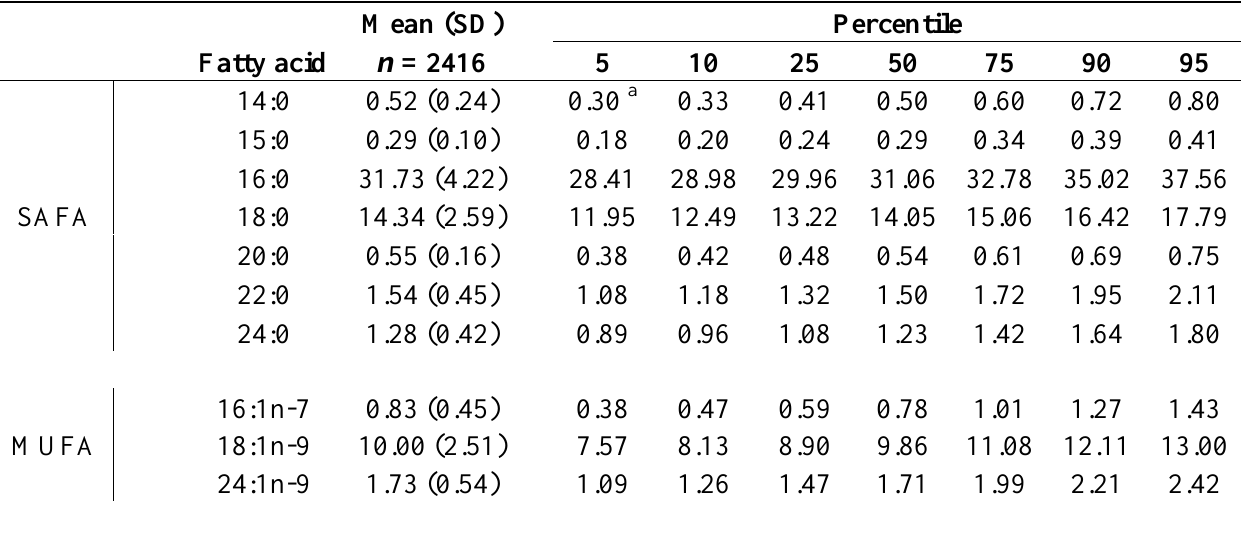
Table 4. National Nutrition Survey participant percentiles for serum phospholipid fatty acid